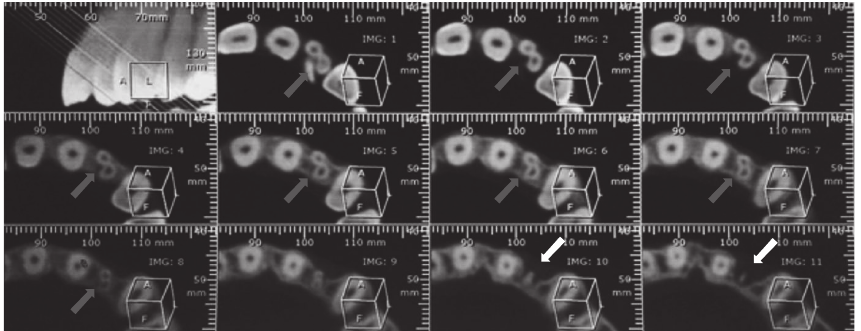
Figure 3: 3D reconstruction of CBCT images with 0.25 mm axial slice thickness and 0.25 mm slice interval. Images 1–8 indicate the presence of two root canals in the maxillary left lateral incisor. Images 10 and 11 show apical rarefaction with destruction of the vestibular cortical